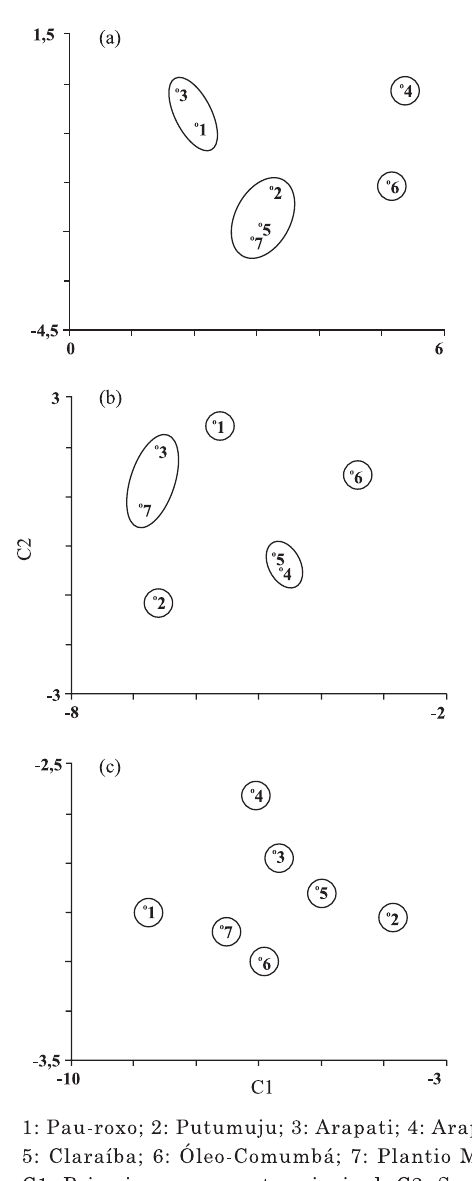
Figura 2. Dispersão gráfica em relação aos dois primeiros componentes principais, com base nas variáveis de intensidade da ciclagem bioquímica (a) e biogeoquímica (b) de N, P, K, Ca e Mg e do balanço (c) de carbono e nutrientes de diferentes plantios florestais no sudeste da